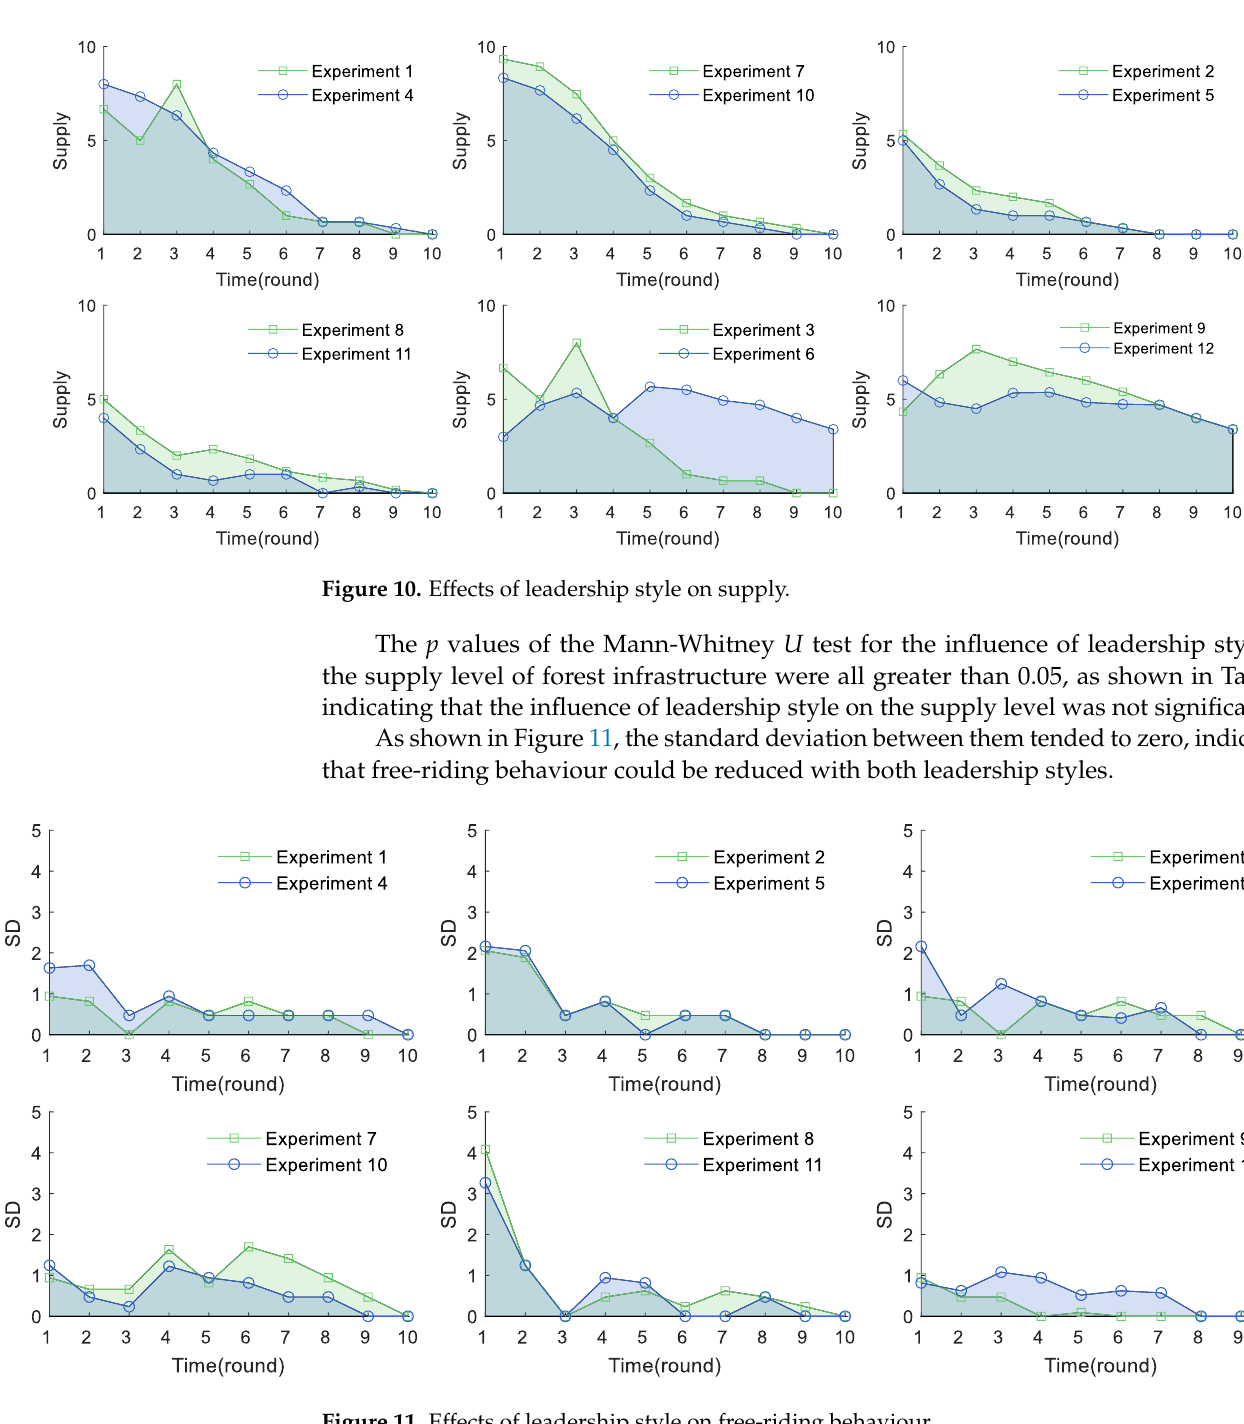
Figure 11. Effects of leadership style on free-riding behaviour.